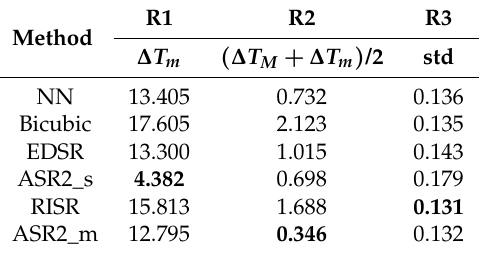
Table 4. Results of the tests on the I2 image with different methods. ∆ T M and ∆ T m are defined in (12) and are expressed in Celsius degrees; std is the standard deviation. For each ROI, highlighted in bold font are the values that best reproduce the regions specific features. Reference values for the